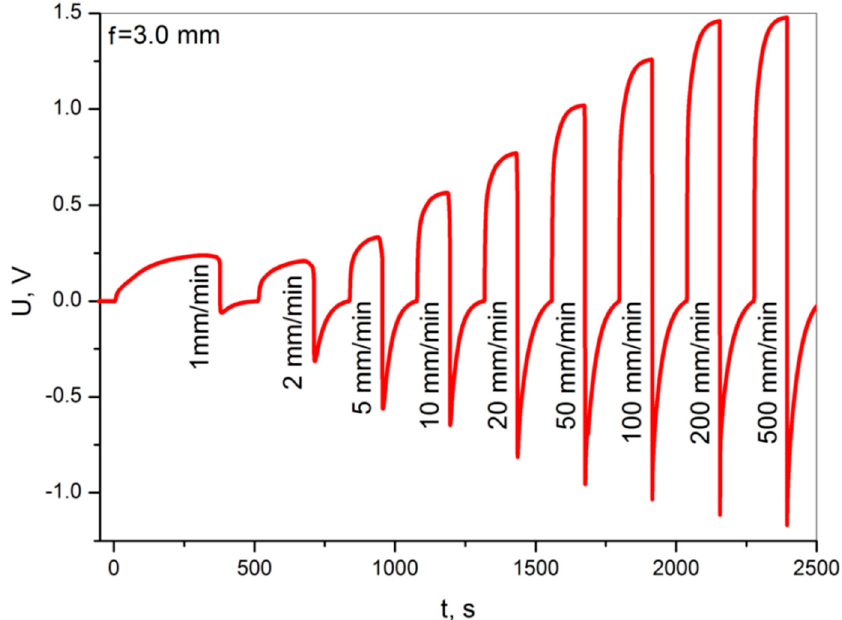
Figure 7. Voltage diagrams obtained during the non-destructive static bending tests at a constant deflection of 3.0 mm, with a variable bending rate of 1–500 mm/min.